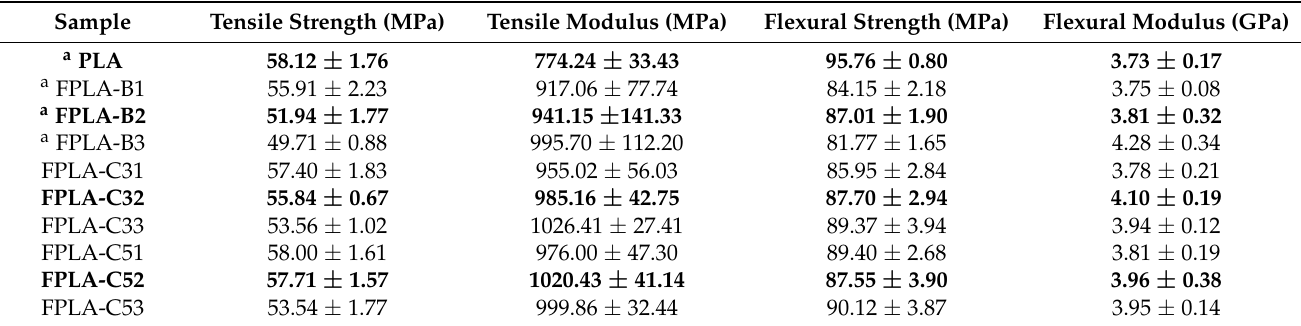
Figure 7. Average mechanical properties of FPLA-B and FPLA-C composites: ( a ) tensile strength, ( b ) tensile modulus, ( c ) flexural strength, and ( d ) flexural modulus; as well as typical tensile stress-strain curves of a selected sample: ( e ) FPLA-B composites and ( f ) FPLA-C composites. Table 3. Mechanical properties of the FPLA-B and FPLA-C